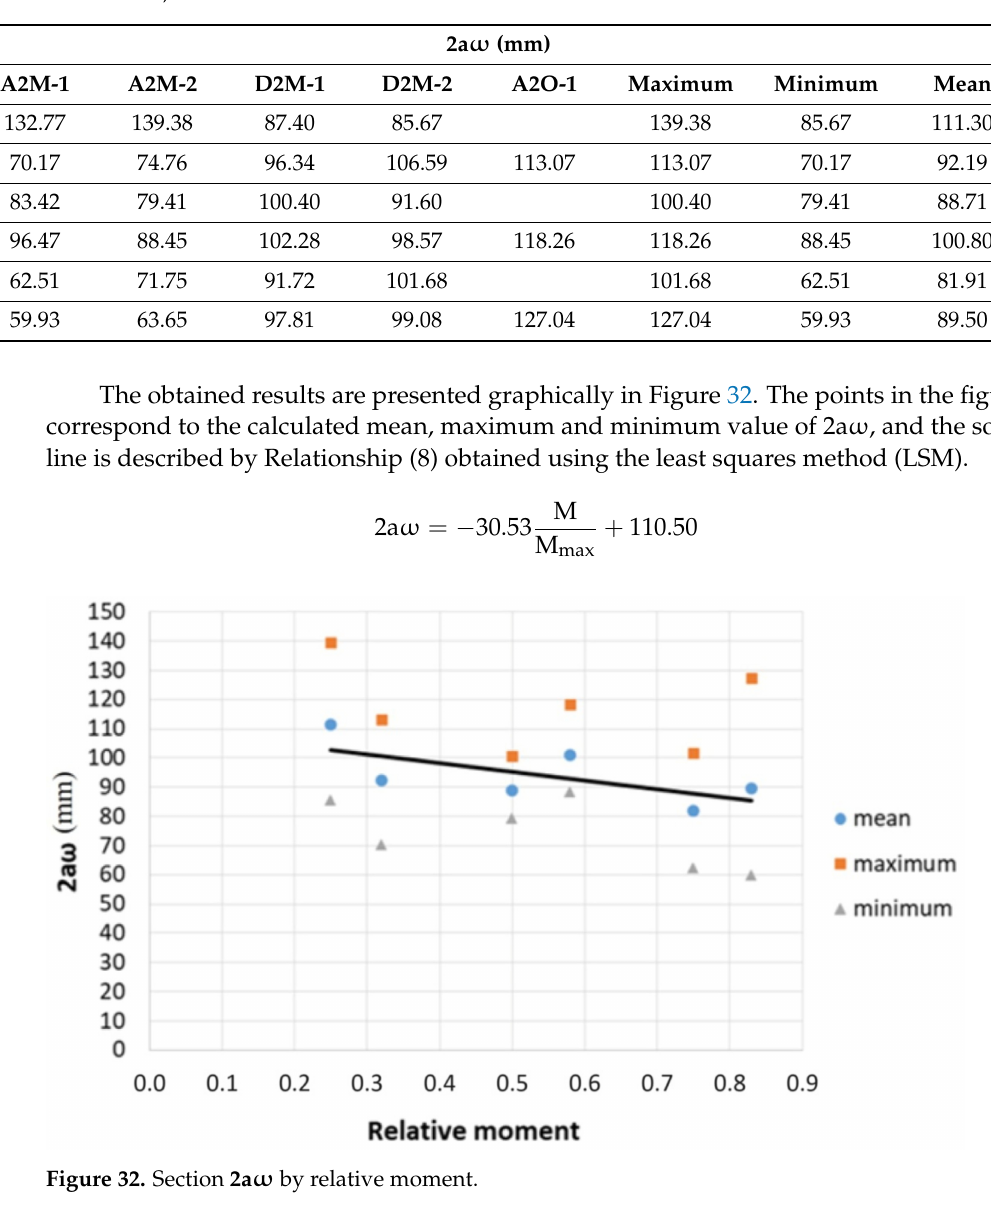
Table 10. Maximum, minimum and mean value of 2a ω for maximum crack width.